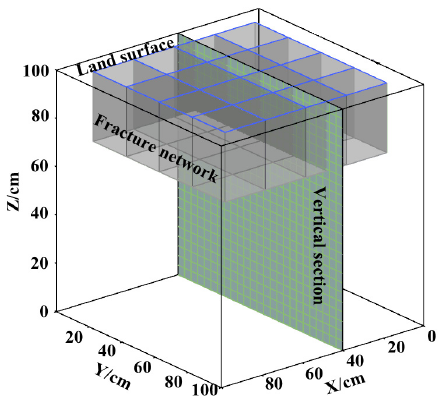
Figure 1. Diagram of S1 experimental setup.